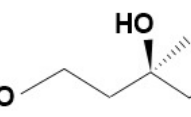
Figure 4. The mevalonic acid (3,5-dihydroxy-3-methylvaleric acid), an important member of the terpene biosynthesis.